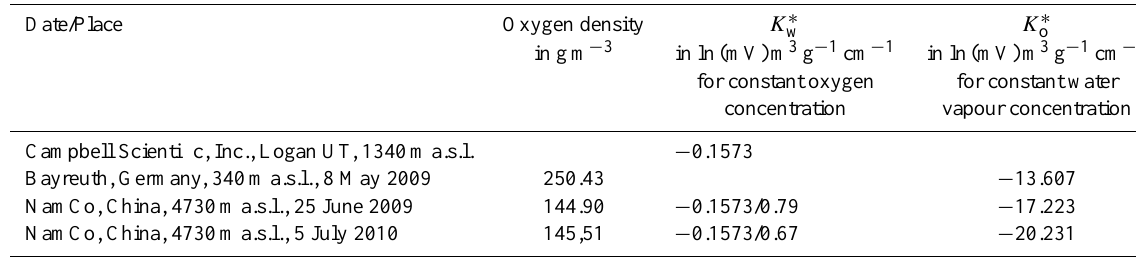
Table 2. Results of calibrations of the Krypton Hygrometer no. 1649 (produced